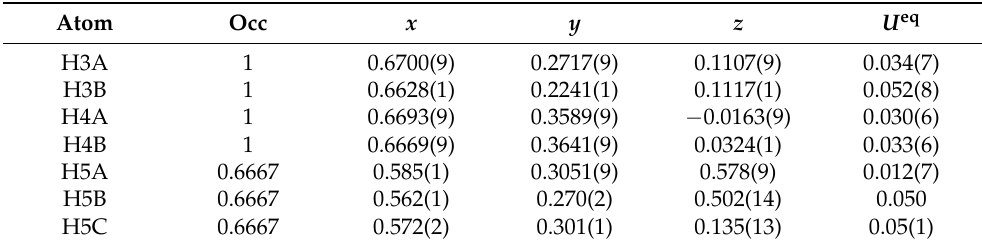
Table 4. Hydrogen atoms coordinates, occupancies (Occ) and displacement isotropic parameters (Å 2 ) for natrophosphate at 100 K.